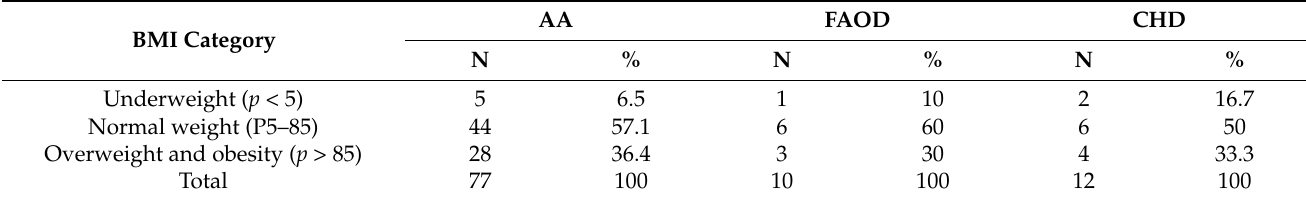
Table 3. Degree of adiposity in intermediary metabolism disorders according to WHO international standards.